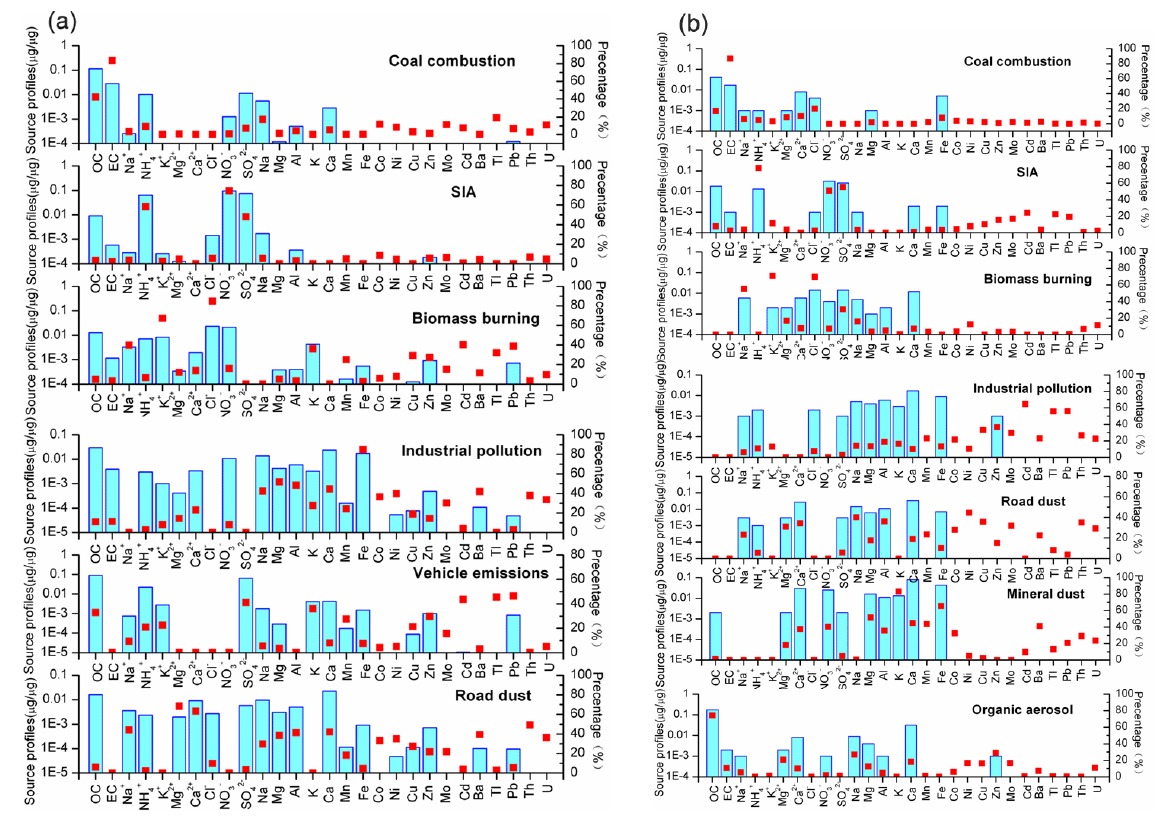
Figure 5. The profiles of each source in (a) fine and (b) coarse